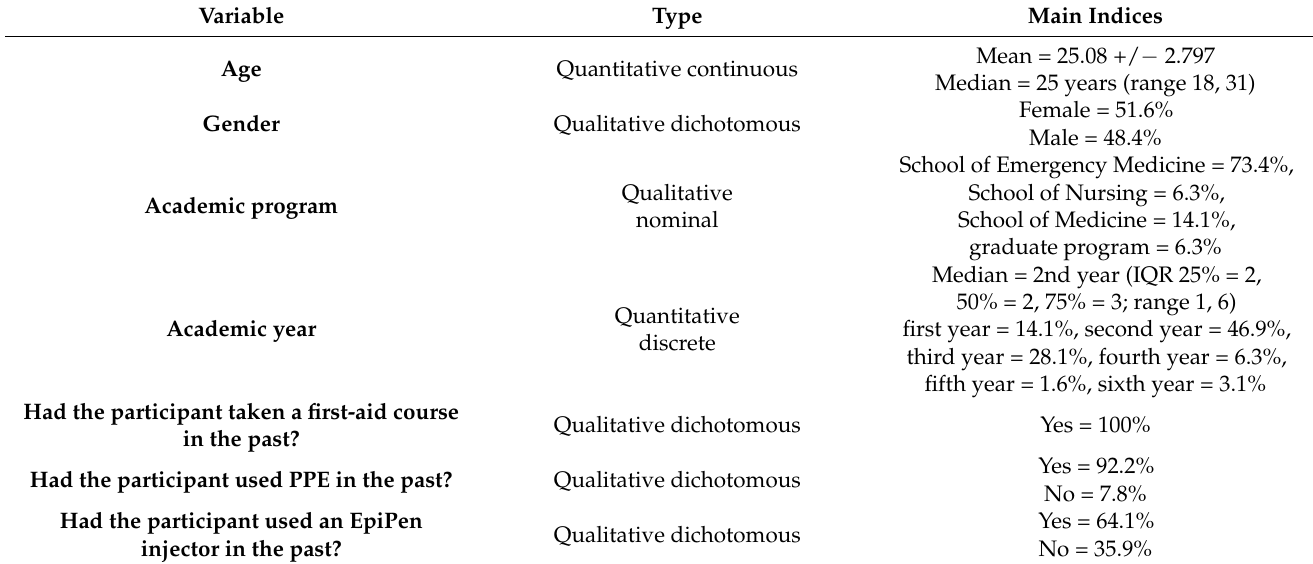
Table 1. Demographic characteristics of the study participants.